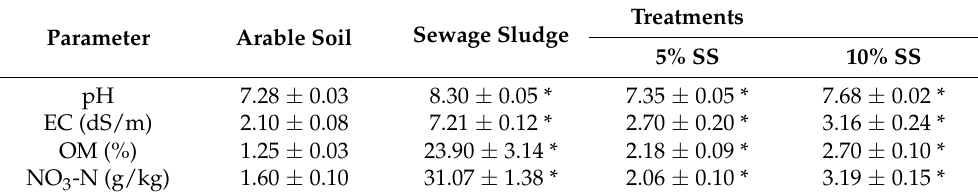
Table 1. Soil properties (mean ± standard deviation, n = 3) used for Ridge gourd ( L. acutangula ) cultivation under different sewage sludge and plant growth-promoting rhizobia (PGPR)